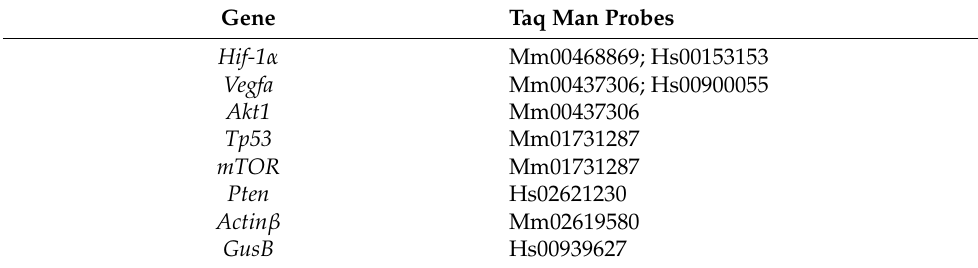
Table 3. List of TaqMan probes used to detect gene expression.